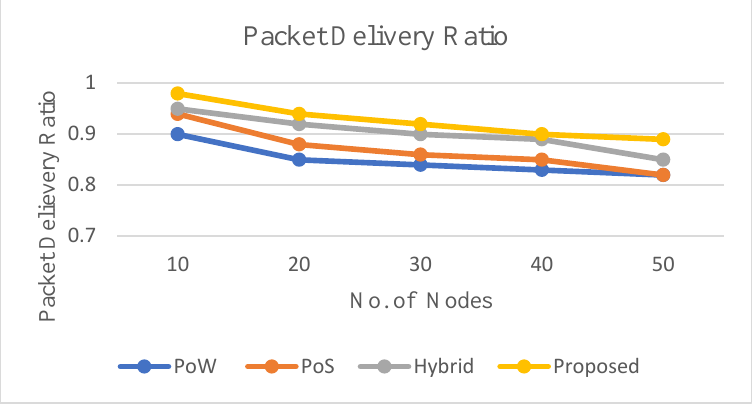
Figure 7. Packet Delivery Ratio.